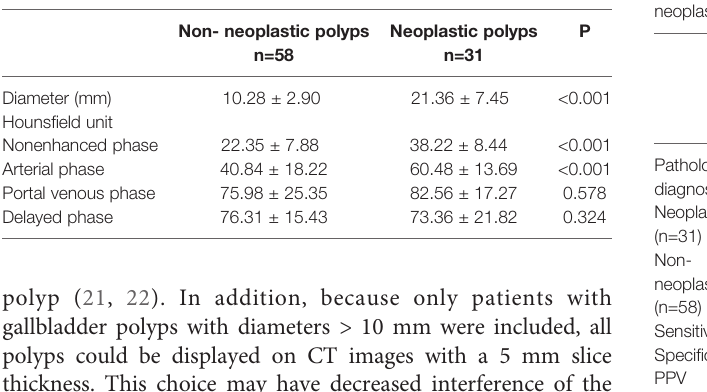
TABLE 3 | CT parameters of neoplastic and non-neoplastic polypoid